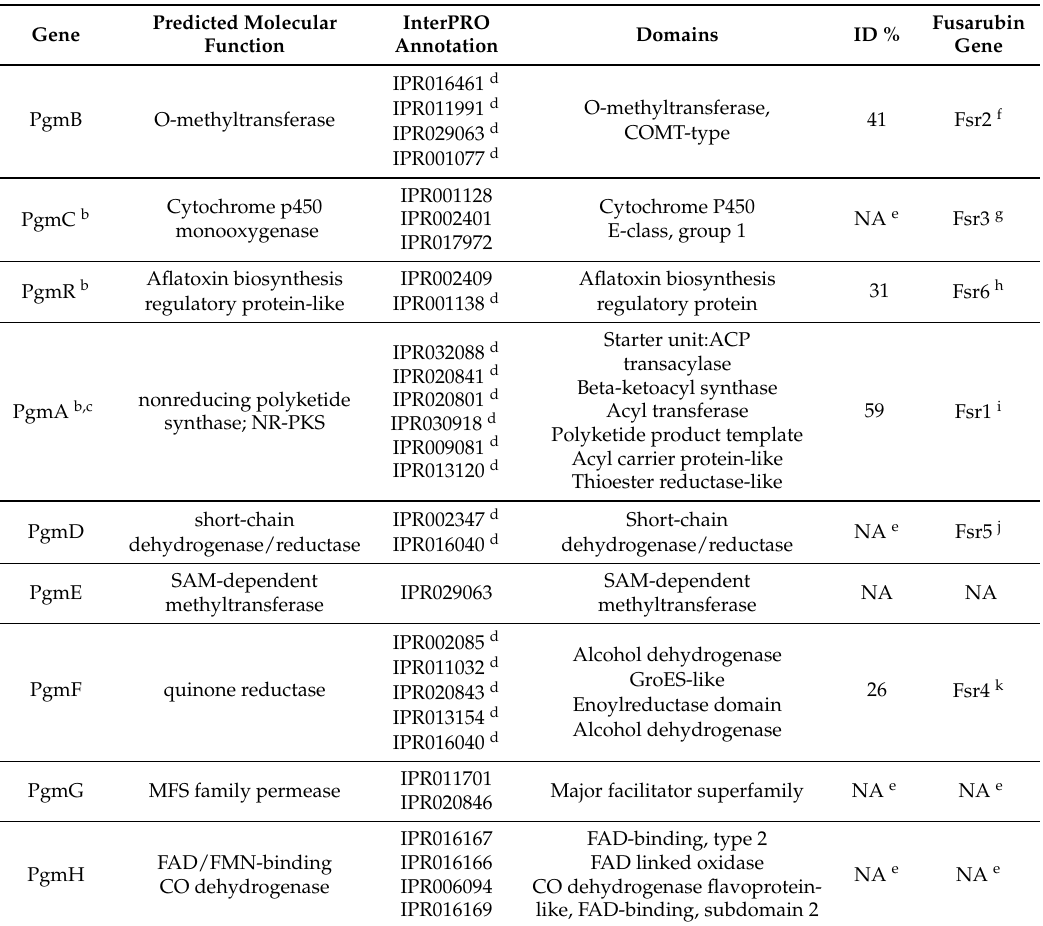
Table 2. Amino acid identity and InterPRO domains of the A. terreus Pgm cluster and F. fujikuroi fusarubin cluster a